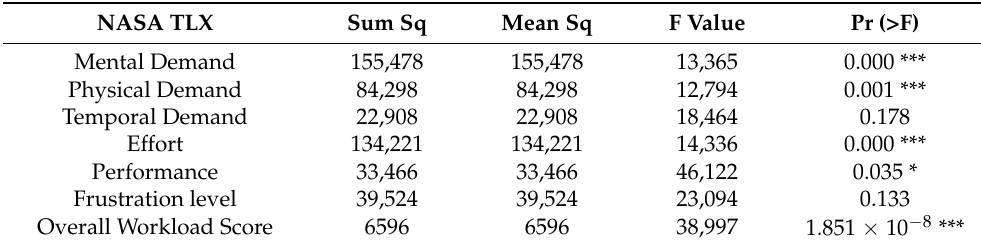
Table 3. ANOVA Test summary of NASA-TLX sources of